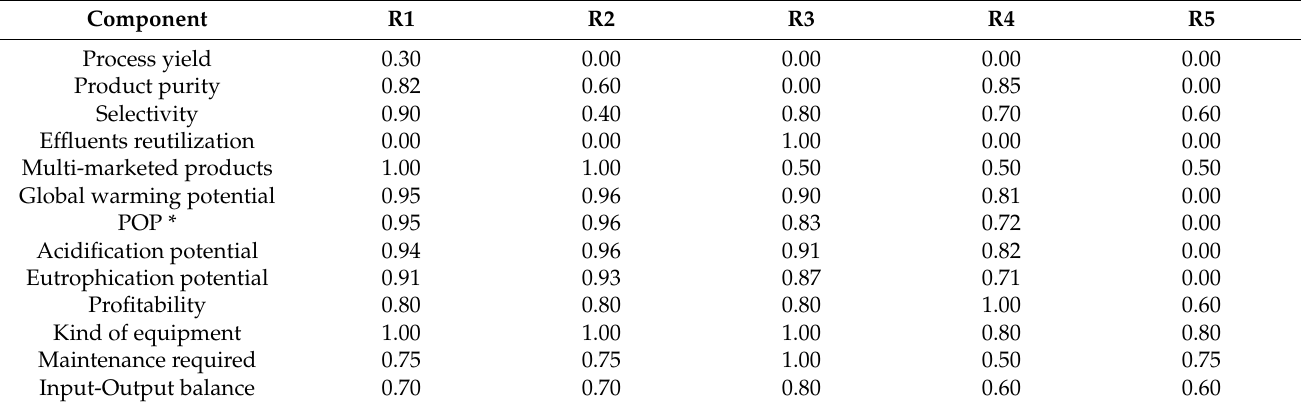
Table 2. CalculatedSustainabilityvaluesforthedefinedcomponents. Casestudy: